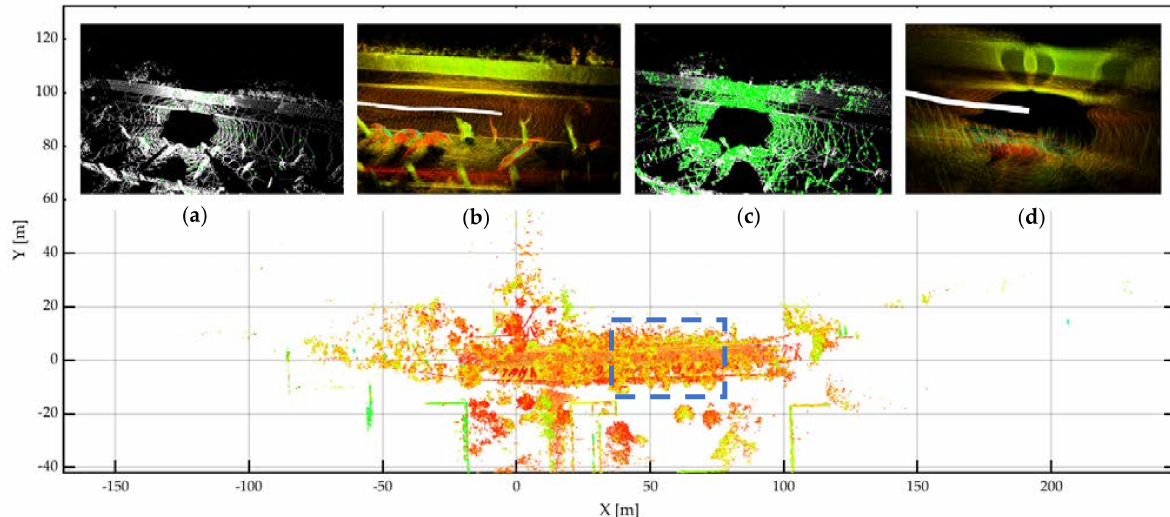
Figure 5. A qualitative example of the good feature selection method. The UGV runs into a narrow district, where the surroundings are blocked by walls. With the lazier–greedy algorithm, only the surface features providing strong geometric constraints are picked in ( a ), and the local map is well maintained in ( b ). On the other hand, once all the surface features are imported in ( c ), the local map in ( d ) is blurred due to textureless regions. The amount of surface points in ( a , c ) are 1125 and 11,243,